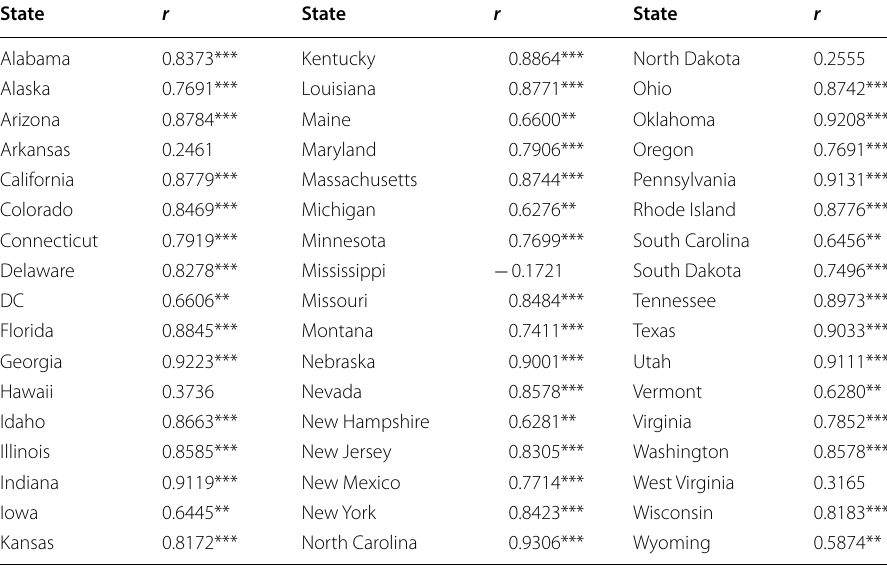
Table 1 Correlations between Google Trends data and Chlamydia cases by state